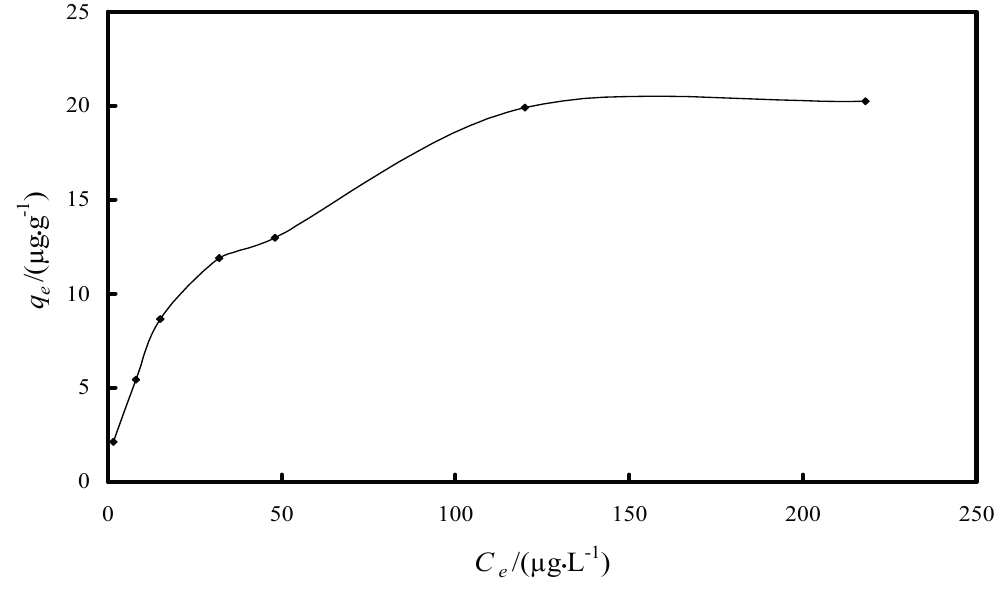
Figure 8. Adsorption isotherm of As(V) ions onto Fe-XAD8-DEHPA resins; T = 298 ± 1 K;